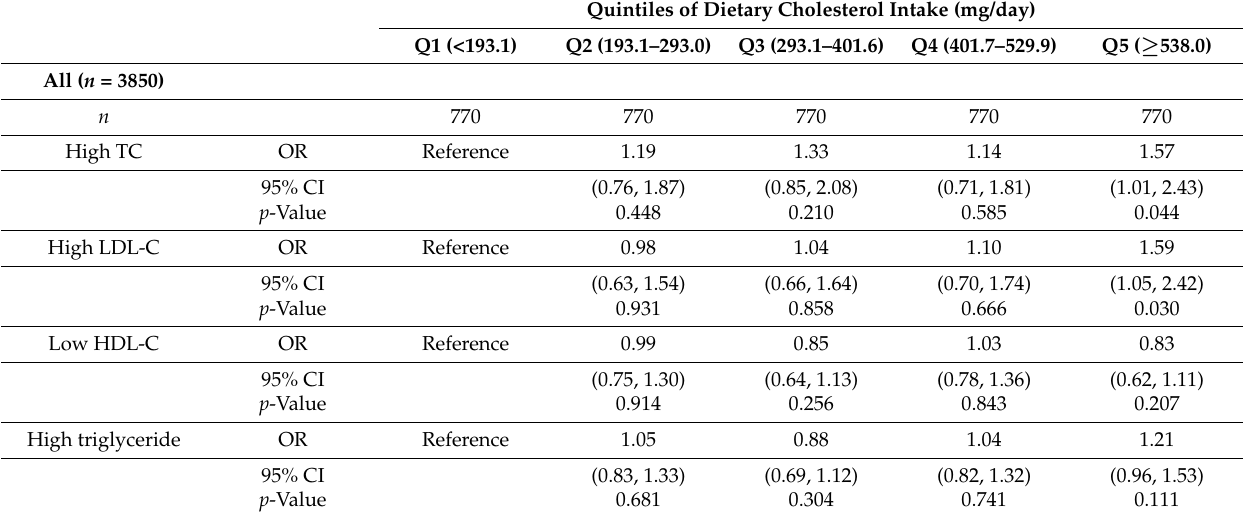
Table 3. ORs (95% CI) for dyslipidemia according to the quintiles of dietary cholesterol intake (mg/day) in SDHS 2012–2013 1